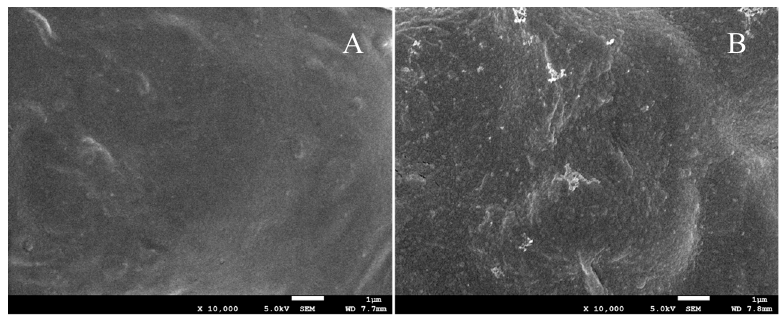
Figure 2. SEM images of ( A ) PC and ( B ) PC 5 films.